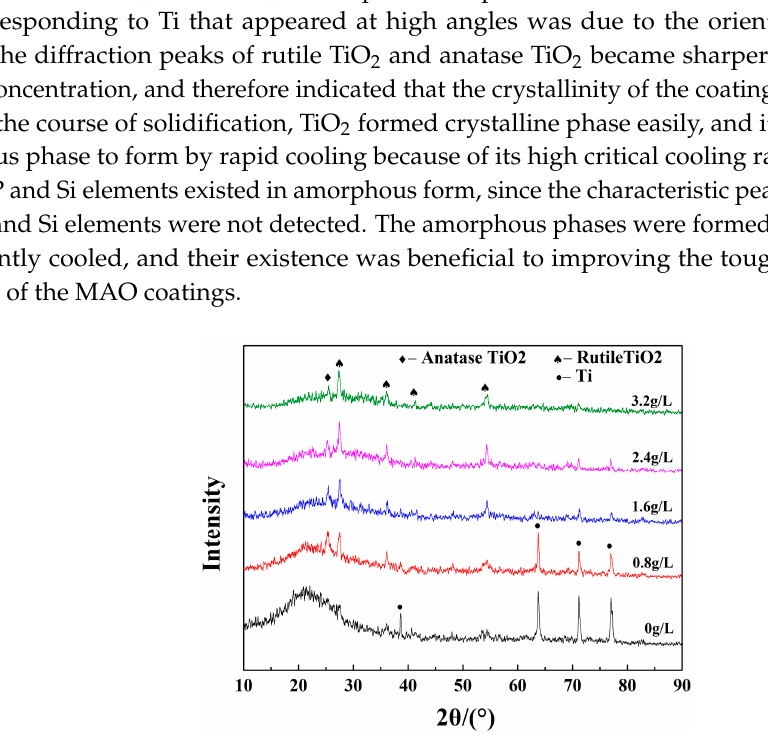
Figure 3. XRD patterns of MAO coatings at different KMnO 4 concentrations.